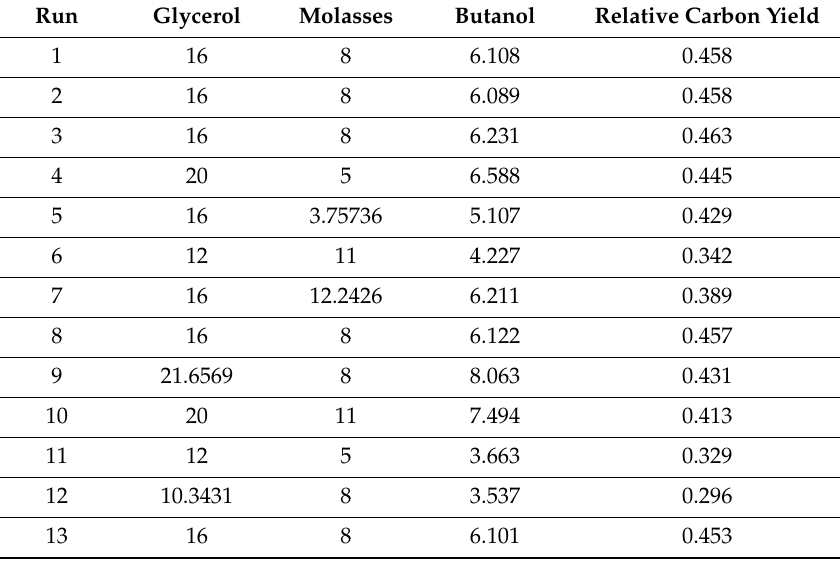
Table 2. Relative carbon yield under conditions determined for identification of an optimum ratio. All conditions were tested in duplicate and the average values are reported here. Deviation from the mean was less than 10% for all